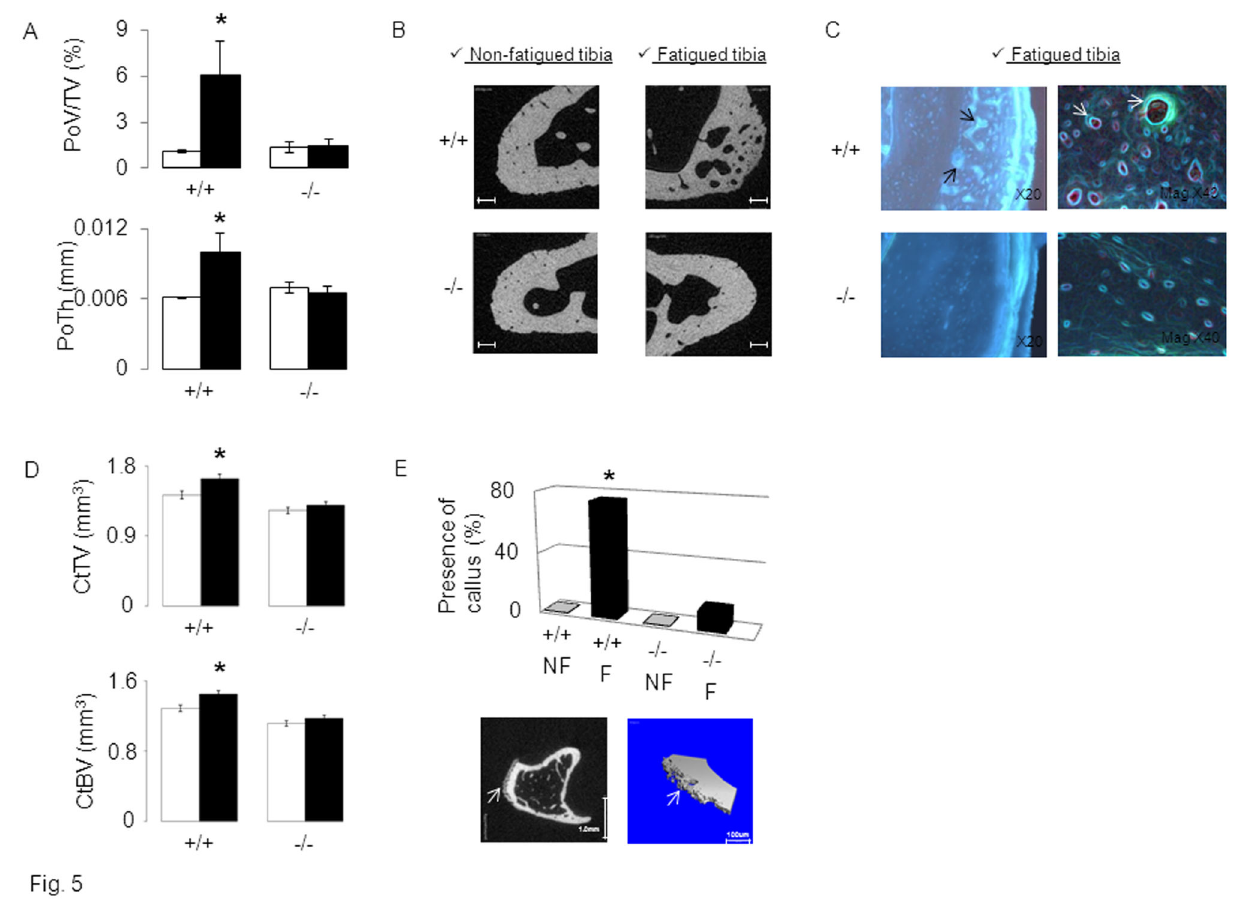
Figure 5. Post-fatigue intra-cortical remodeling and callus response in Postn -/- vs Postn +/+ mice. Cortical bone parameters were evaluated by micro-CT 15 days after axial compression. A) Cortical porosity volume on tissue volume (PoV/TV) and Pore Thickness (PoTh). (B) 2D illustration of cortical porosity, bars scales 100um. (C) Intra-cortical remodeling indicated by calcein labeling around cortical pores (arrow indicate intense double labeling). (D) Cortical Bone Volume (CtBV) and Cortical Thickness (CtTh, mm) at proximal tibia. (E) Percent of mice presenting a callus in fatigued (F) vs non-fatigued (NF) tibia. Lower panel: arrow indicates periosteal woven bone on 2D and 3D micro-CT images of fatigued tibiae in Postn +/+ mice. * p<0.05 compared to non- fatigued tibia ( Fisher’s PLSD following 2F-ANOVA). Bars show mean (± sem) of n=6-8 animals /gr, black bars: fatigued tibia, white bars: non-fatigued